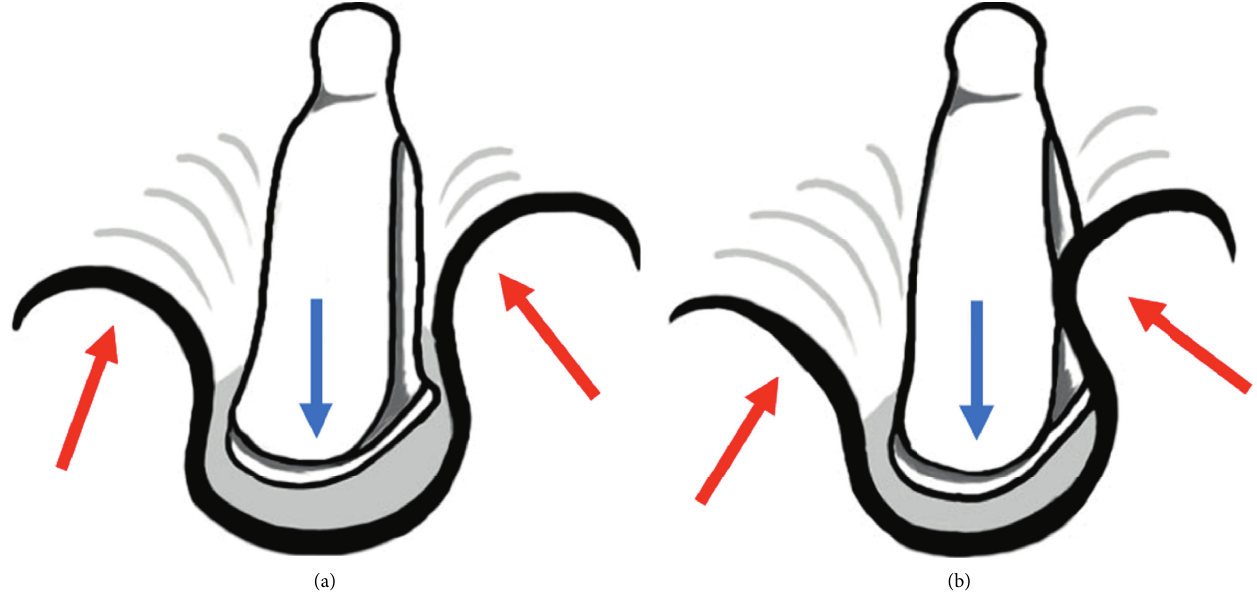
Figure 3: The proposed theory for congenital stapedial suprastructure fixation with normal footplate mobility. During development, the stapes enlarges medially toward the otic capsule, and the otic capsule enlarges laterally toward the stapes (a). The bulging mesenchyma of the otic capsule makes direct contact with the developing stapedial mesenchyma